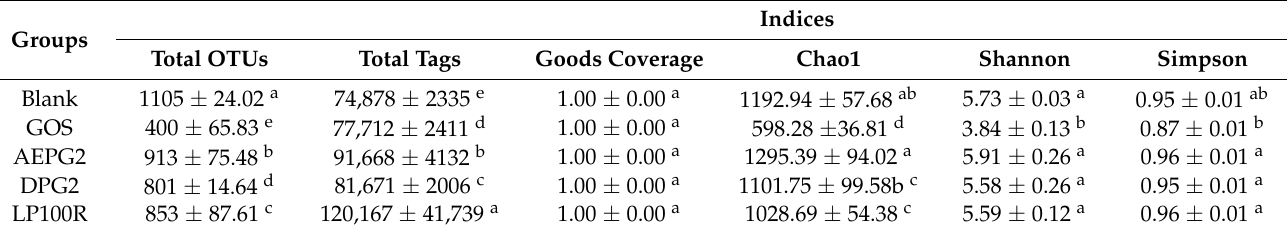
Figure 5. Concentrations of SCFAs in fermentation broths at different time points of fermentation in vitro. Different lowercase letters indicate significant differences ( p < 0.05) among different samples at the same time. n = 3. Table 2. Alpha diversity of samples among different treatment groups.